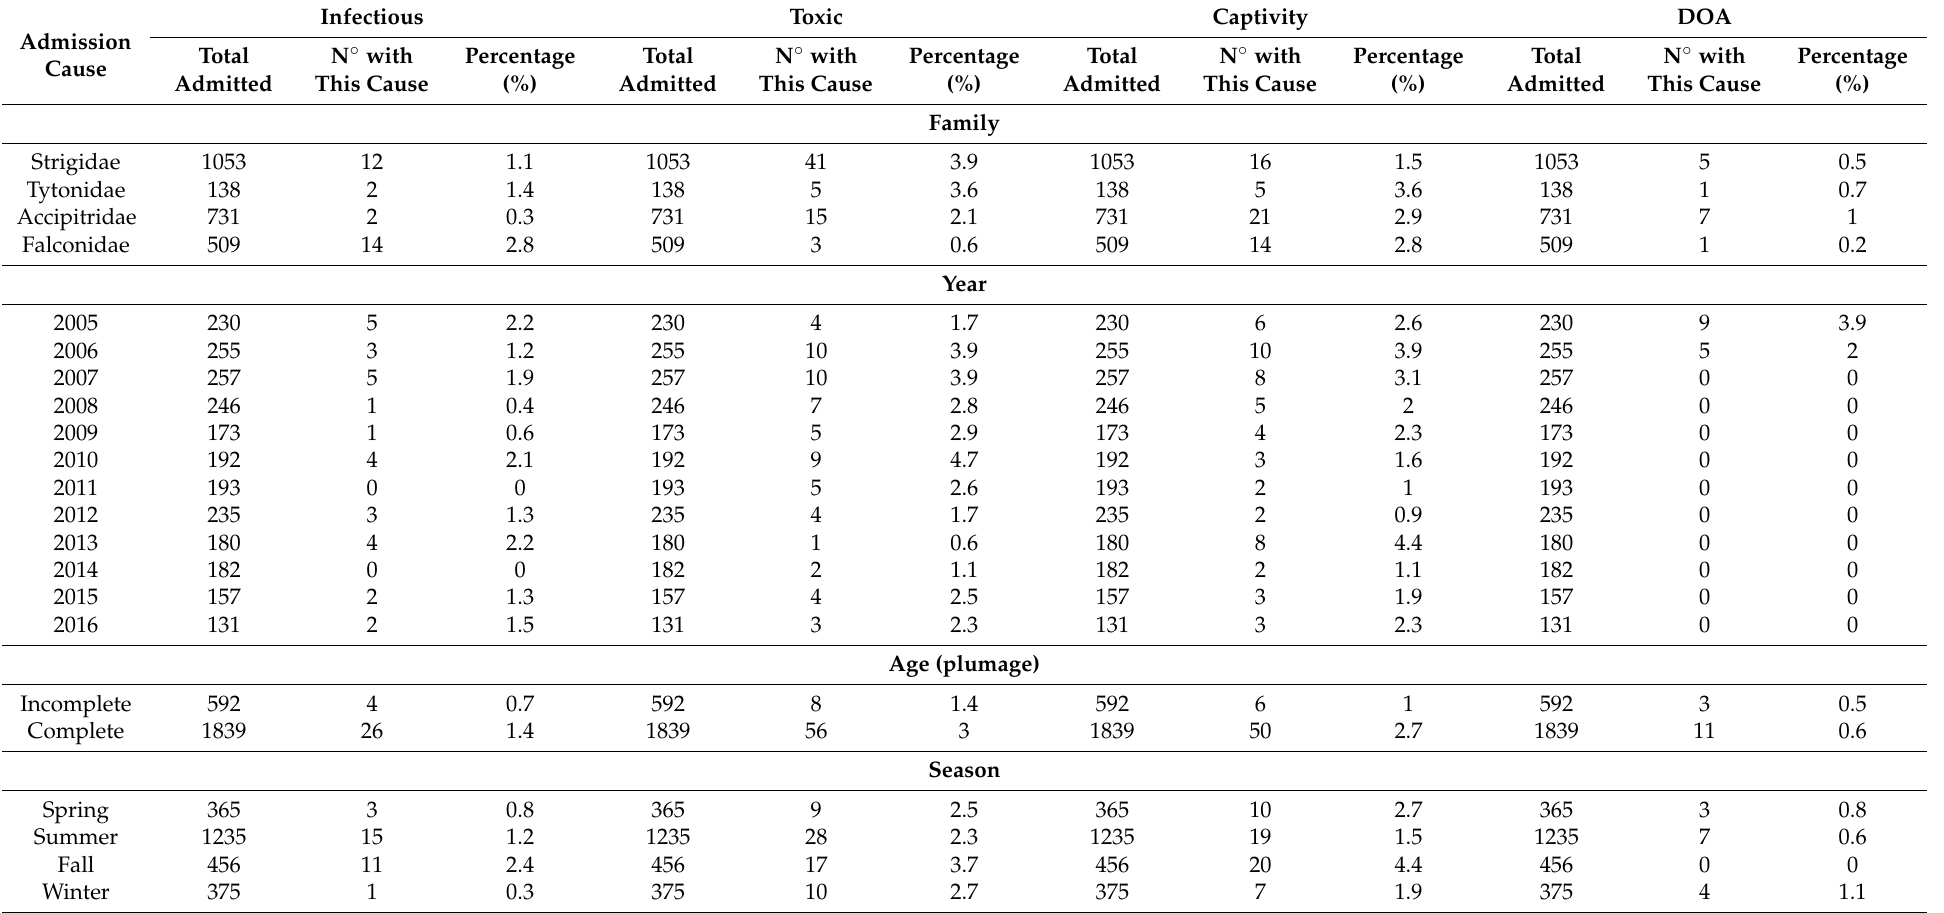
Table 2. Descriptive statistics for each cause of admission included under the label “other causes of admission” (infectious disease, intoxication, captivity, and dead-on-arrival